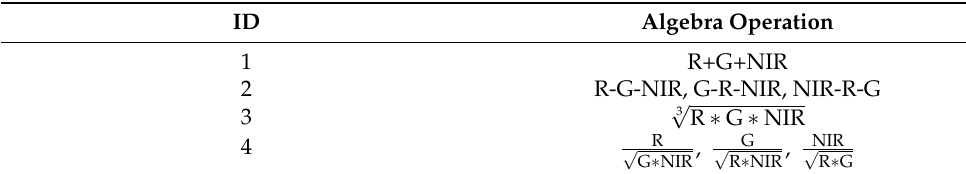
Table 6. Equation combinations of the G, R, NIR.